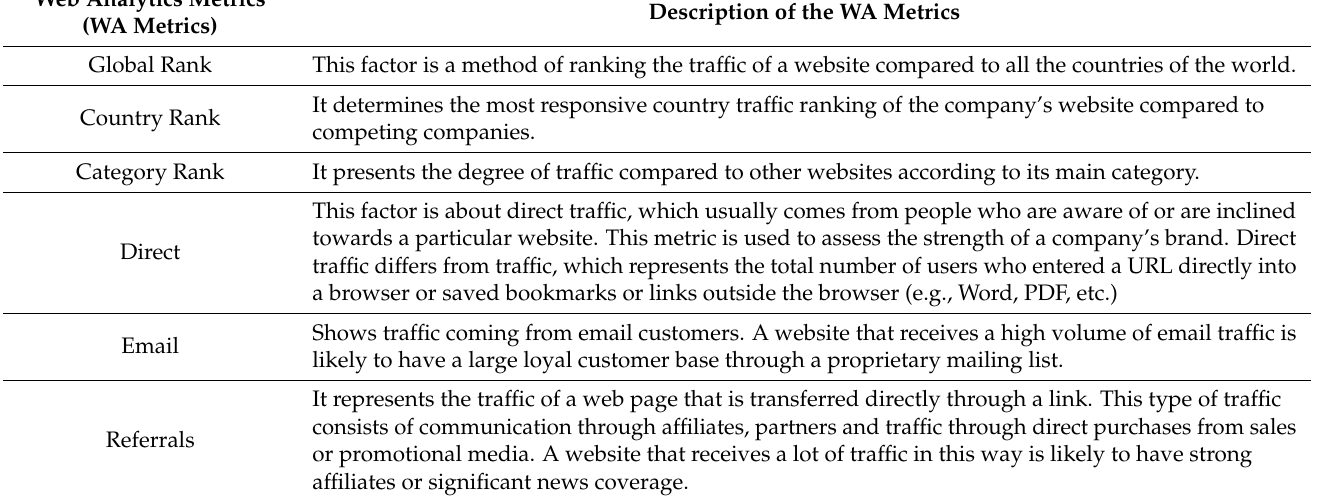
Table 1. Description of the web analytics metrics considered for the role of digital marketing in new product